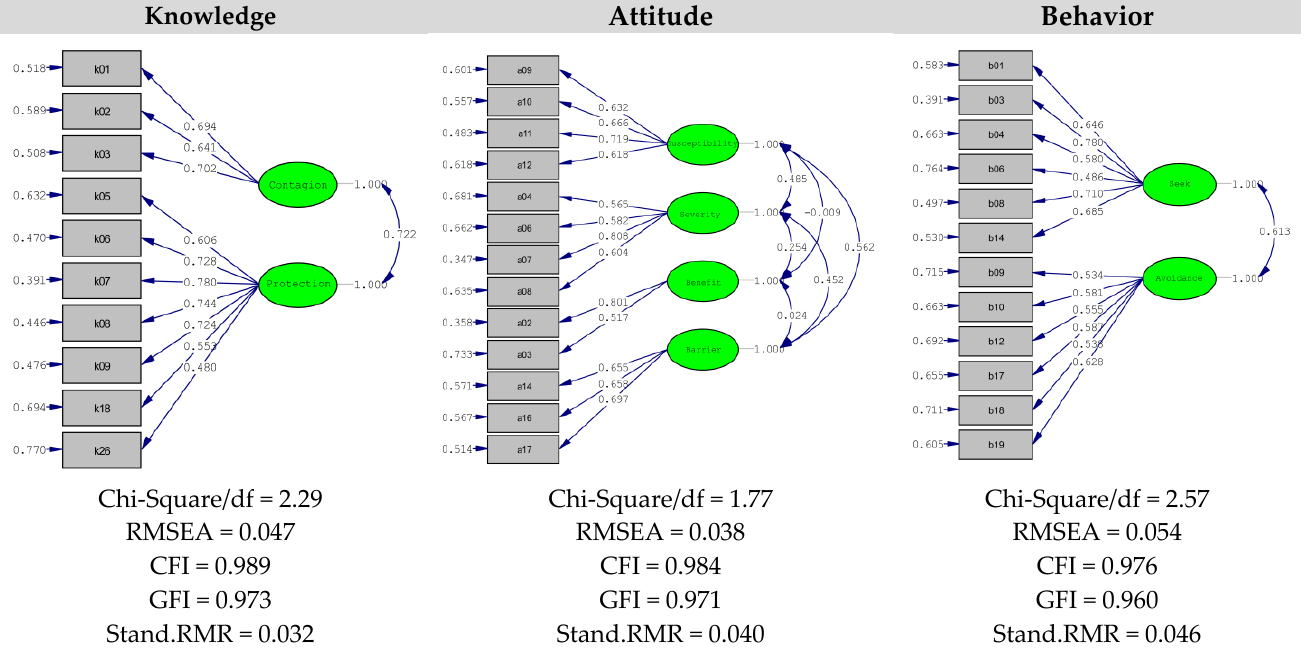
Figure 1. Confirmatory Factor Analysis Results. RMSEA: The Root Mean Square Error of Approxi- mation, CFI: The Comparative Fit Index, GFI: Goodness of Fit Index, Stand.RMR: Standardized) Root Mean Square Residual.